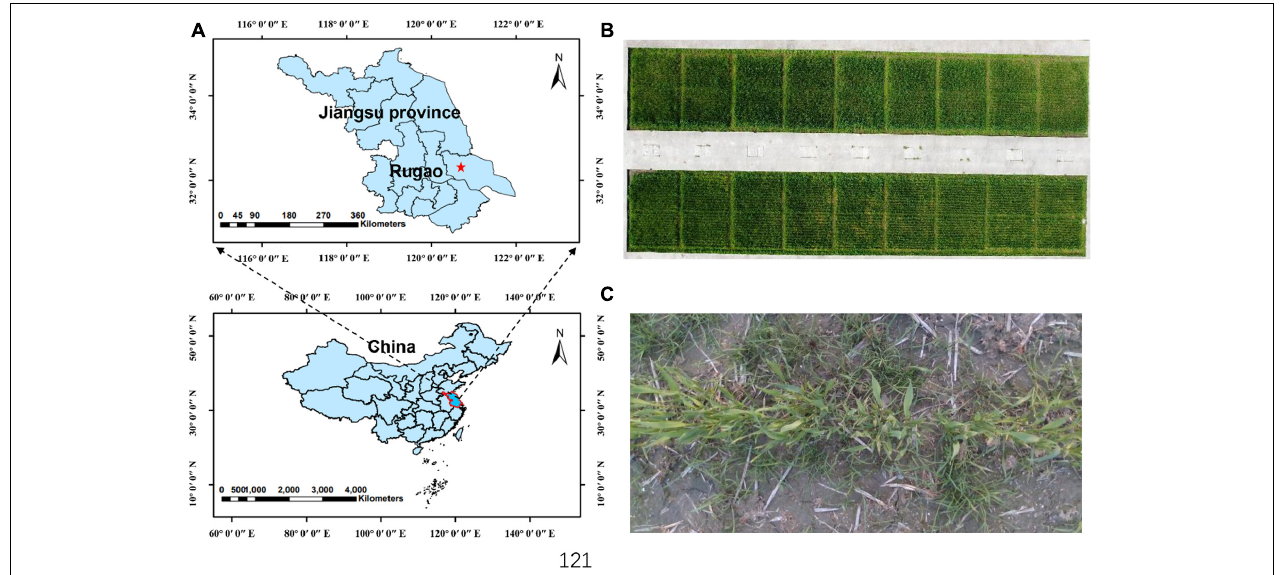
FIGURE 1 | (A) Experimental site; (B) Images of all plots; (C) RGB image of wheat field. The red star represents the location of our experiments in the map.